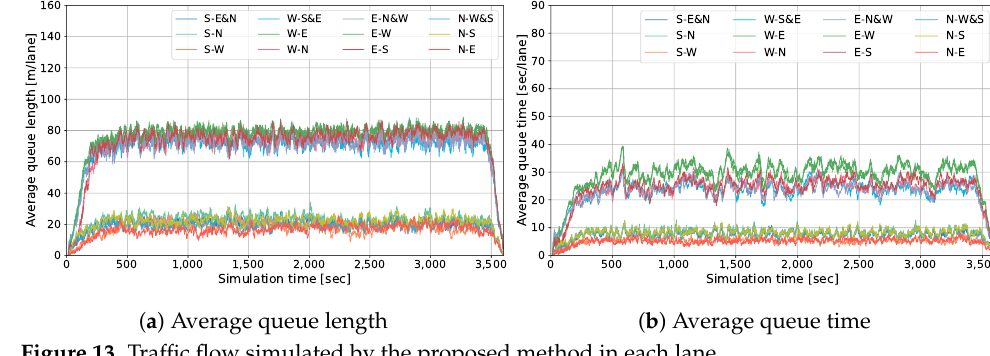
Figure 13. Traffic flow simulated by the proposed method in each lane.